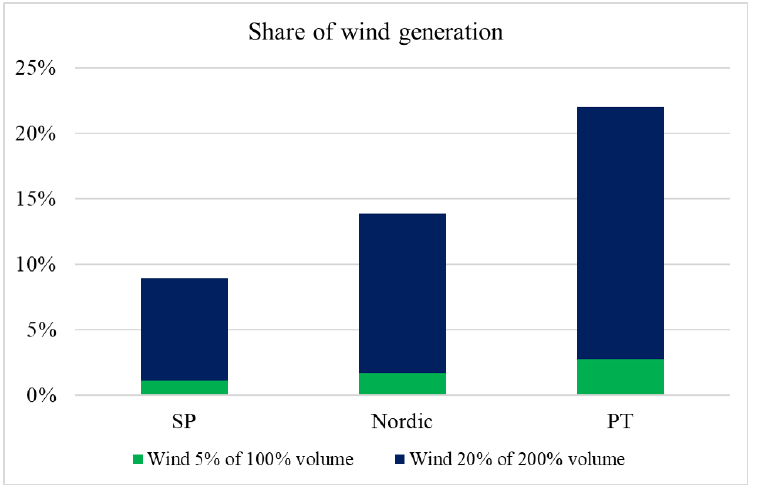
Figure 1. Share of wind generation in FRR-M/RR markets , assuming market volumes of 2017 and double that and 5–20% share of wind power producers in the markets (original